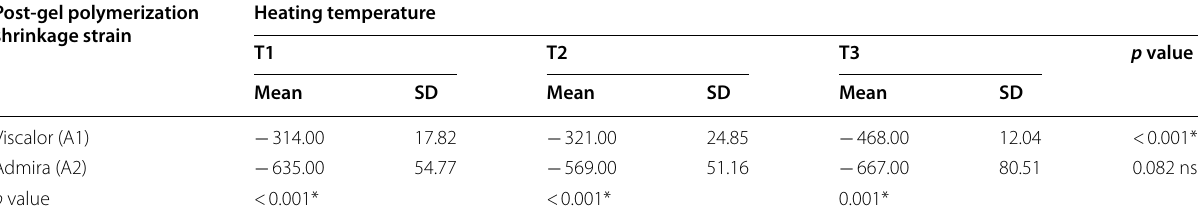
ns: non-significant ( p > 0.05) *Significant ( p <